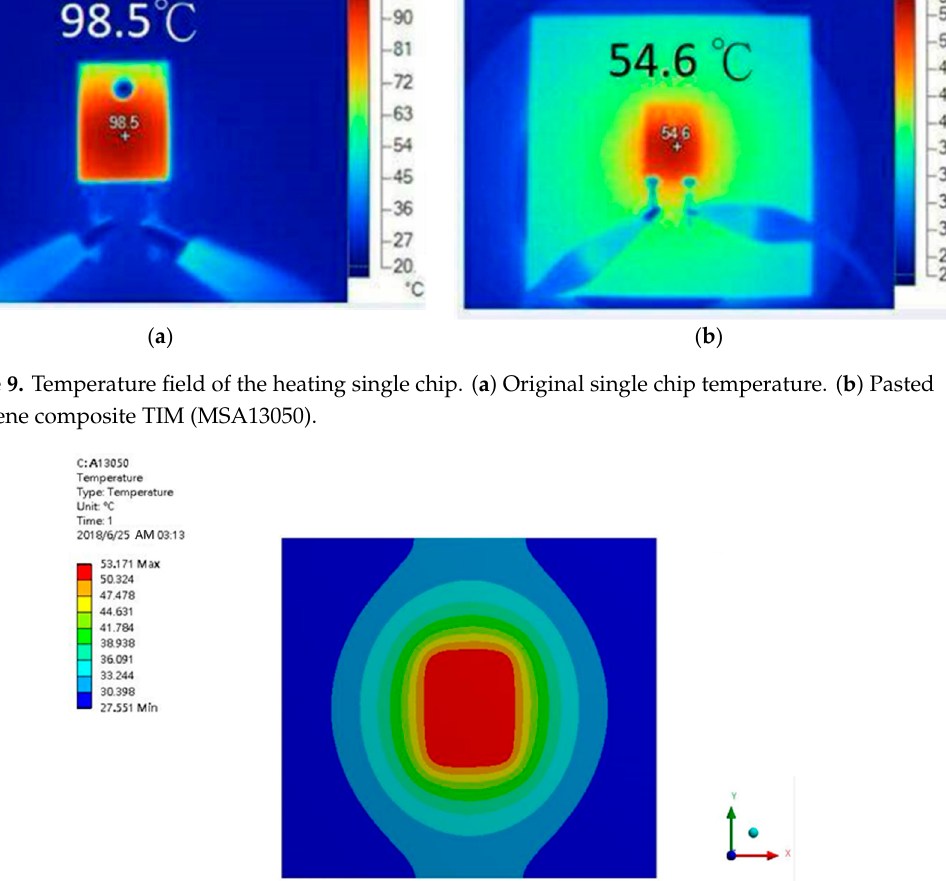
Figure 10. Temperature field distribution of thermal conductivity of 235.5 W/mK.